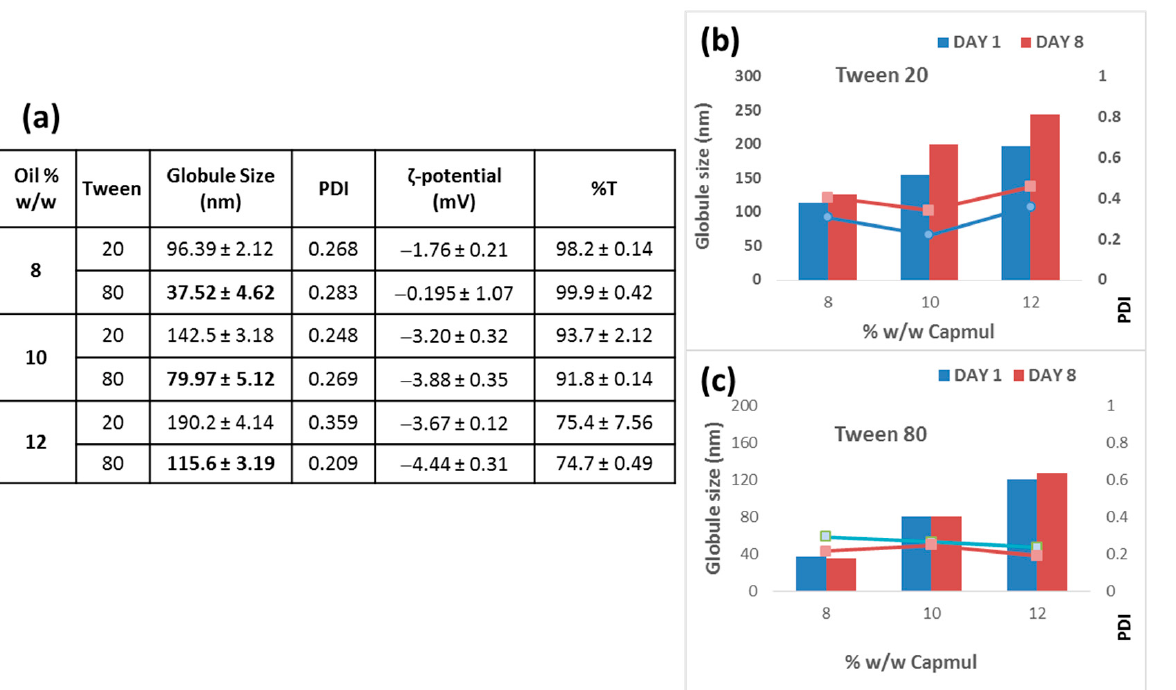
Figure 3. Physicochemical properties of the NEs composed of Tween 20 (as surfactant), with 8% Capmul MCM as the oil and various S + Smix percentages (from 24% up to 44%).